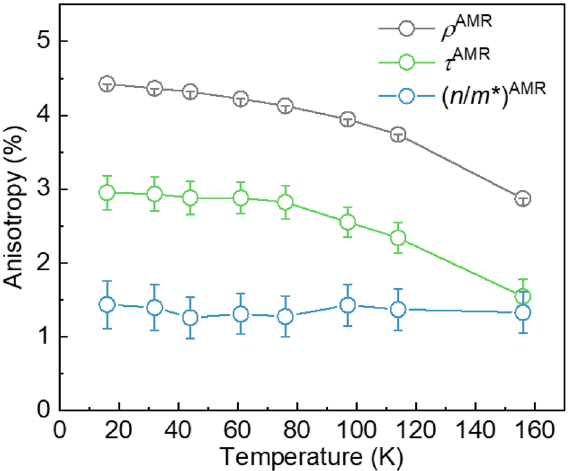
Figure 3. Intrinsic and extrinsic contributions to total AMR. Anisotropy ratios of ρ dc , THz (gray), τ (green) and ( n / m ∗ ) (blue) as a function of the temperature. Here, ρ ( n / m ∗ ) AMR represent the extrinsic and intrinsic contribution to AMR. The error bars for ρ AMR are smaller than the symbol